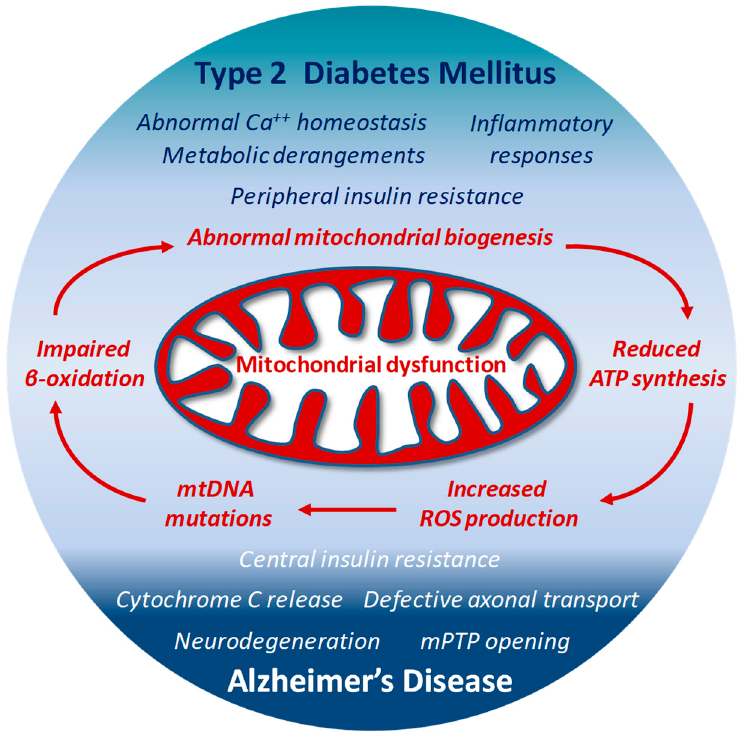
Figure 2. Structural and functional alterations in mitochondria by either defective insulin signaling, or neurodegenerative mechanisms may represent a connecting point between T2DM and AD-associated abnormal brain insulin metabolism.